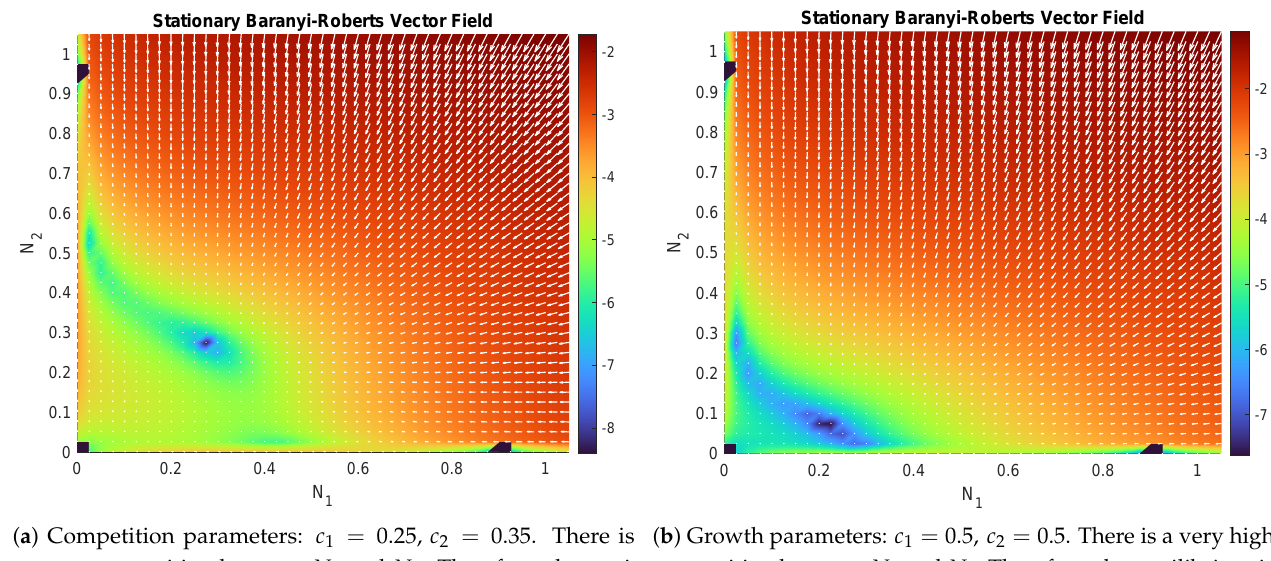
( a ) Competition parameters: c 1 = 0.25, c 2 = 0.35. There is ( b ) Growth parameters: c 1 = 0.5, c 2 = 0.5. There is a very high greater competition between N 1 and N 2 . Therefore, the equi- competition between N 1 and N 2 . Therefore, the equilibrium is librium is obtained closer to the origin than in the case of the obtained very close to the origin. previous Figure. Figure 2. Comparison of the flow function g ( · ) and its log-magnitude, log ( (cid:107) g ( · ) (cid:107) 2 ) , given by the Baranyi–Roberts system (9) and (10) with the set of parameters described in each figure, and K 1 = 0.9, K 2 = 0.95, ν 1 = 0.3, ν 2 = 0.15, r 1 = 0.2, r 2 = 0.55 in both figures. In darker color, the four equilibrium points given by the solutions of the nonlinear system (11) and